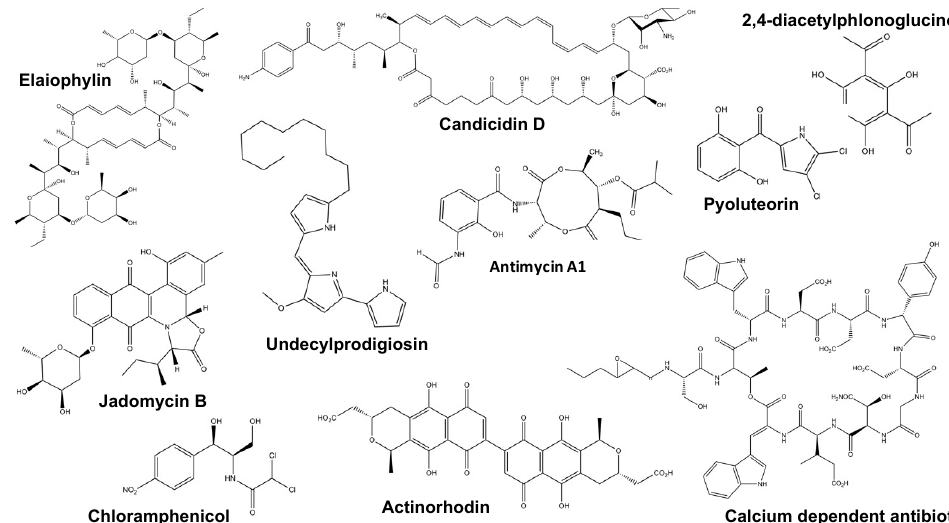
Figure 2. Structures of some of the compounds referenced in this review. The biosynthesis of these compounds is controlled by cross-cluster regulators.